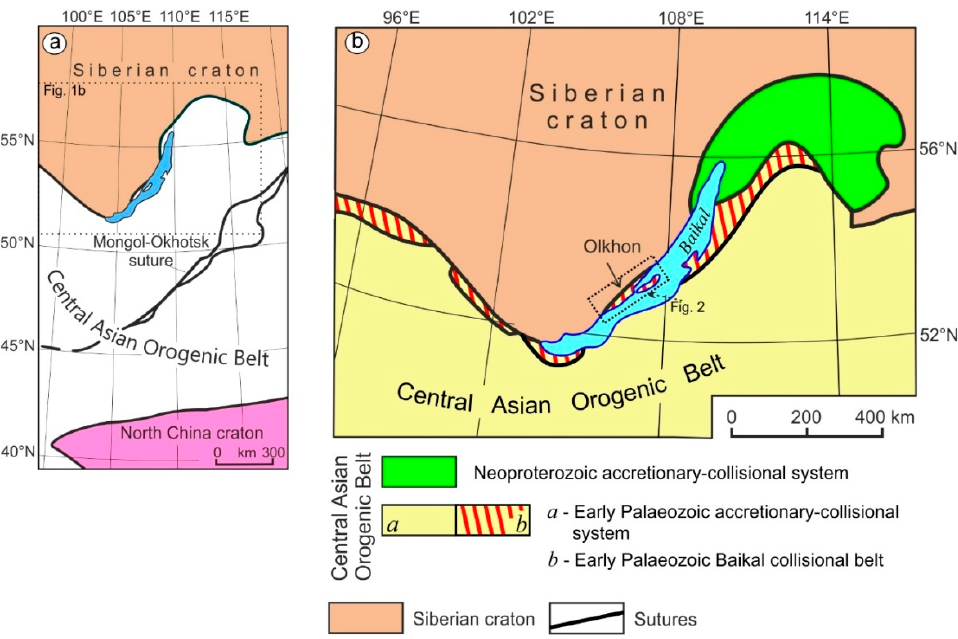
Figure 1. Simplified tectonics of Central Asia ( a ) and terranes in the Early Palaeozoic Baikal collisional belt of northern CAOB ( b ), modified after [16].